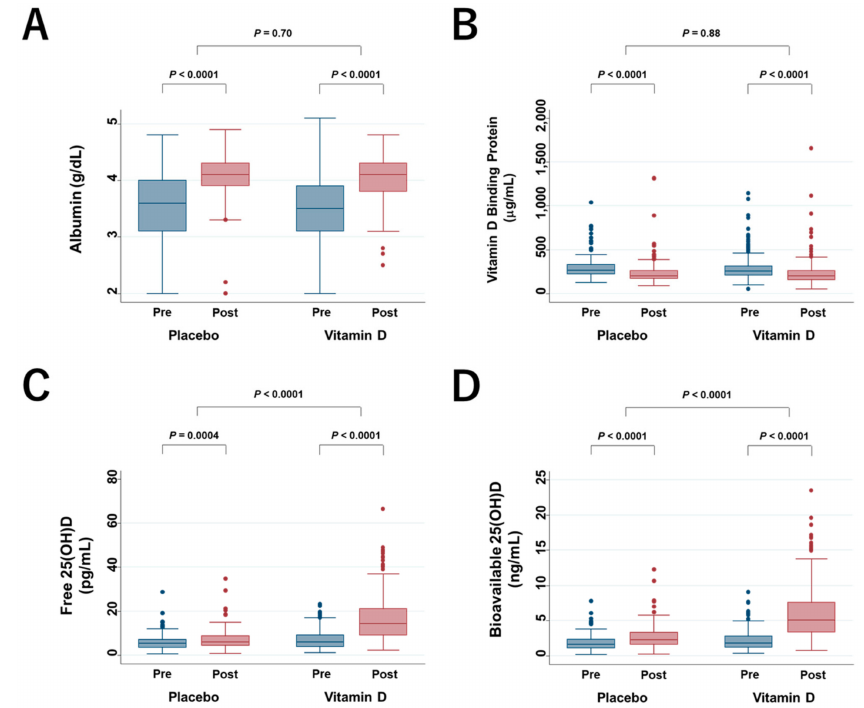
Figure 1. Box plot of changes in serum albumin levels ( A ), vitamin-D-binding protein ( B ), free 25(OH)D ( C ), and bioavailable 25(OH)D ( D ). Pre: just before taking trial supplements; post: 1 year after beginning to take the supplements; 25(OH)D: 25-hydroxyvitamin D.